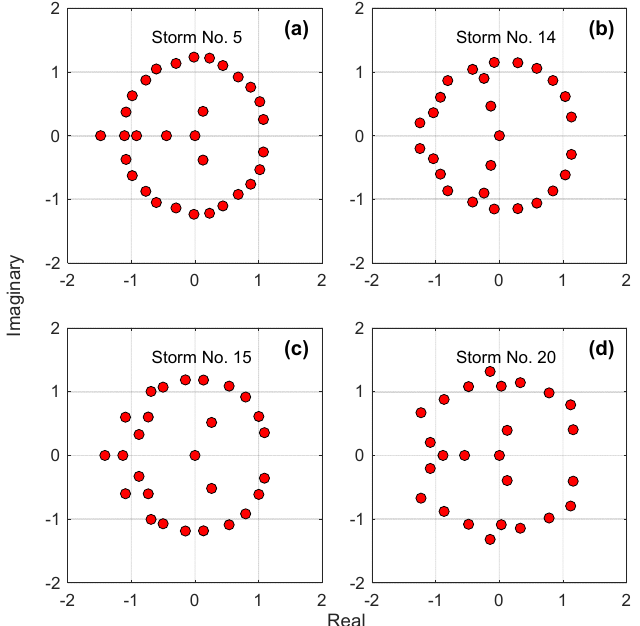
Figure 5. Argand diagrams obtained by the conventional RS method for selected storms of Nenagh basin: ( a ) for Storm No. 5; ( b ) for Storm No. 14; ( c ) for Storm No. 15; ( d ) for Storm No. 20.